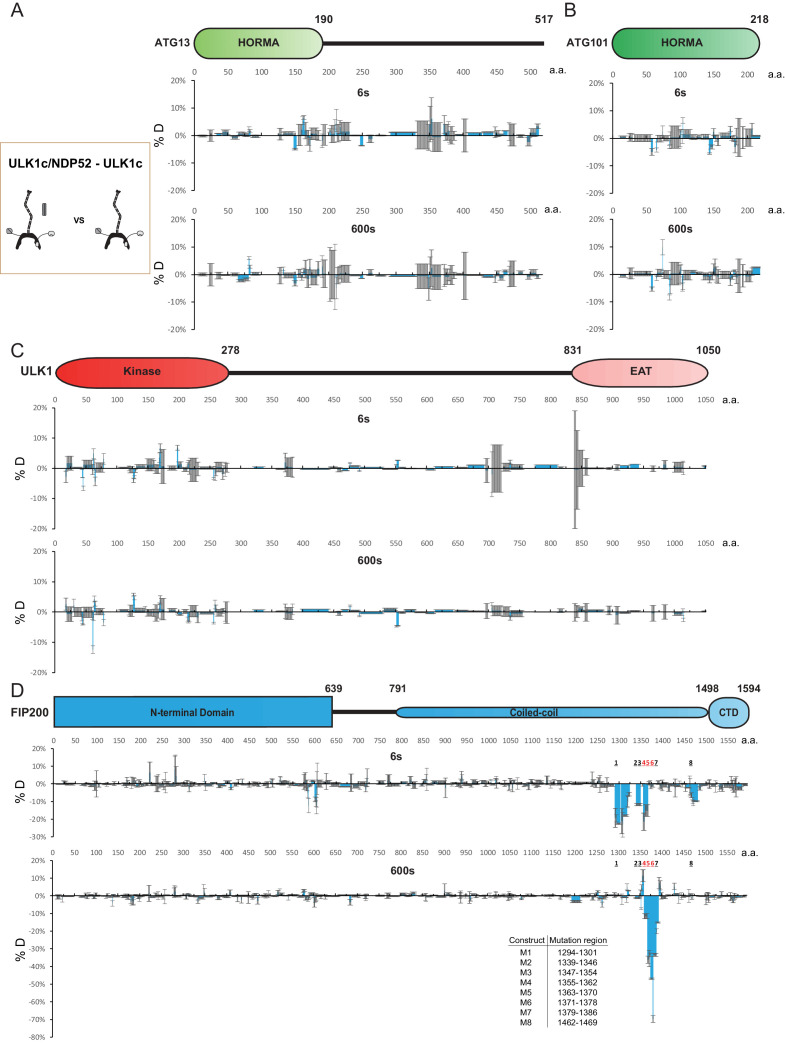
HDX-MS analysis of the interaction of the ULK1 complex with NDP52.(A–D) Difference of Hydrogen Deuterium Exchange percentages of the ATG13 (A), ATG101 (B), ULK1 (C) and FIP200 (D) in ULK1 complex vs in ULK1 complex with NDP52 at the 6 s and 600 s time point. All values are mean (Blue) ± SD (Grey).